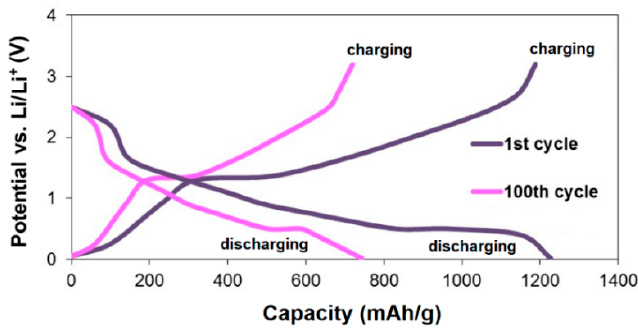
Figure 10. Selective discharge/charge voltage profiles of sample Ti5Mo5 at a current density of 50 mA/g.